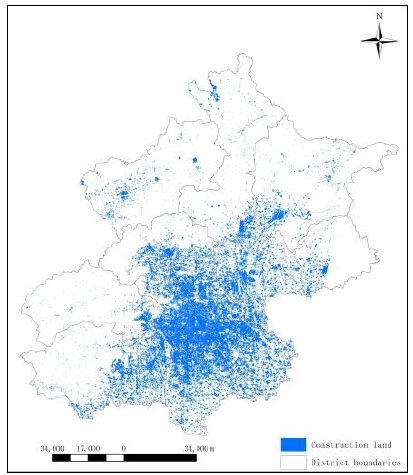
Figure 4. Extraction of construction land